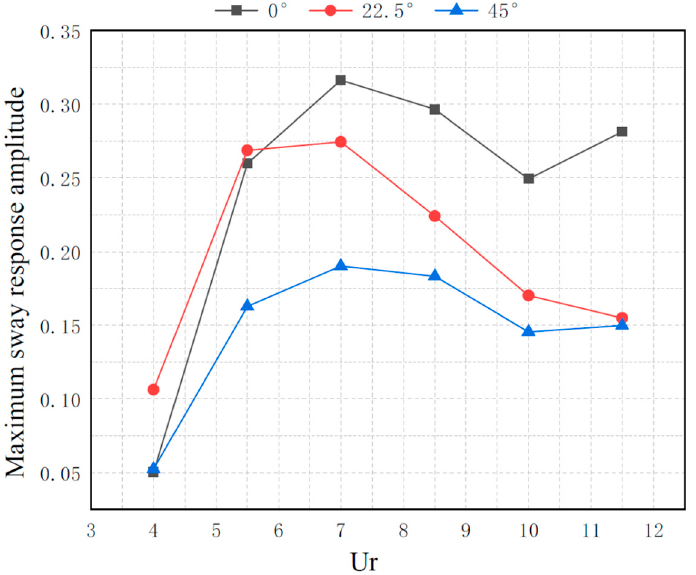
Figure 3. Maximum response amplitude of floating body sway under three flow angles.